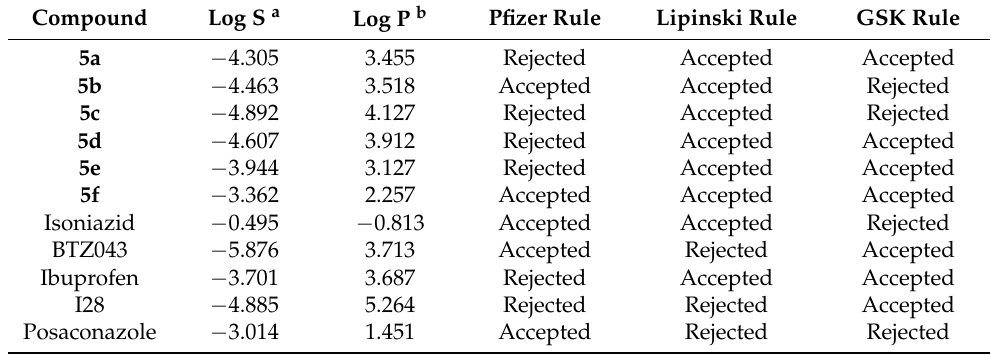
Table 6. A summary of the ADMET properties for 5a – f and the control molecules.